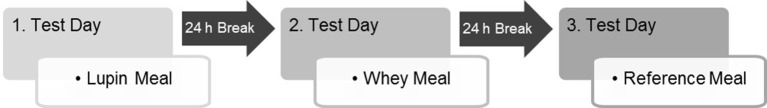
Exemplary testing protocol for one subject.